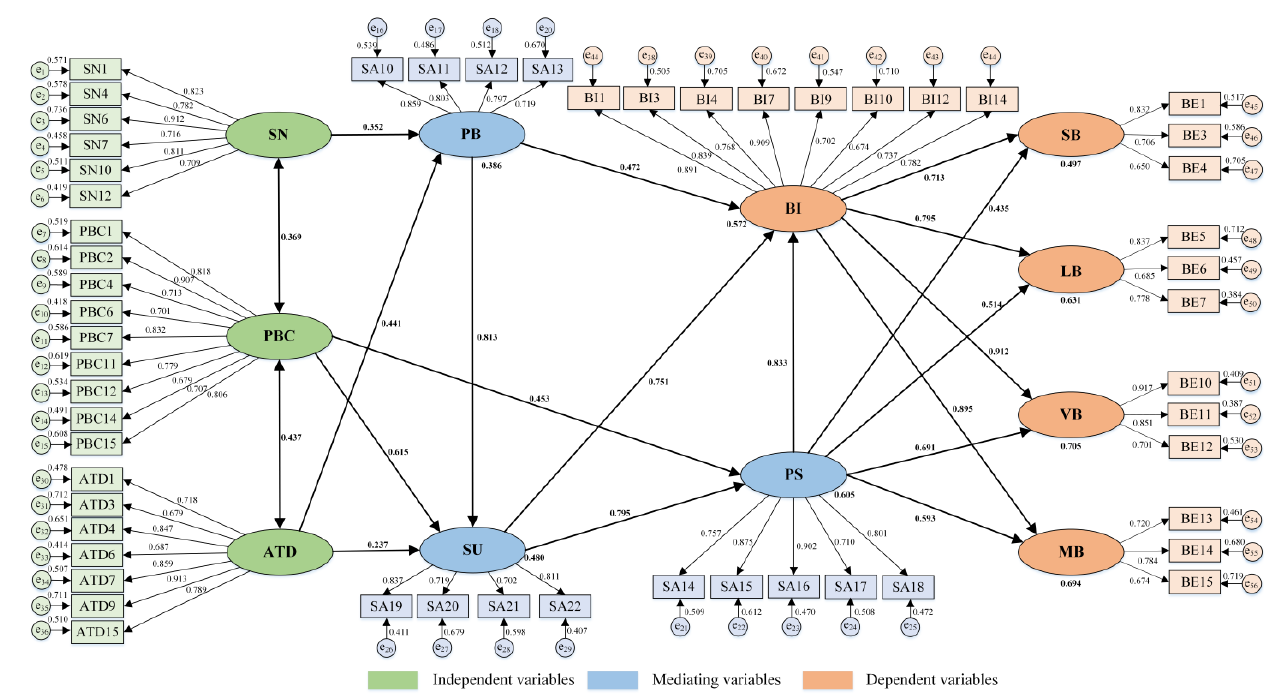
Table 8. After modified model-fit indices.